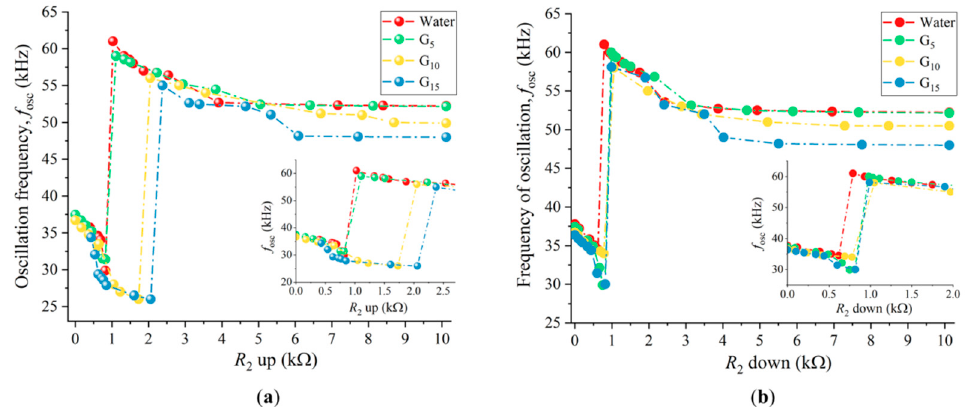
Figure 2. Experimental oscillation frequencies of the self-excited microcantilever as function of the phase-shift introduced by the PS, with fixed R 1 and polarity ( p = − 1). ( a ) Potentiometer R 2 swept up; ( b ) potentiometer R 2 swept down. Insets detail the jump regions and G 5 , G 10, and G 15 indicate the concentration of the glycerol solutions.